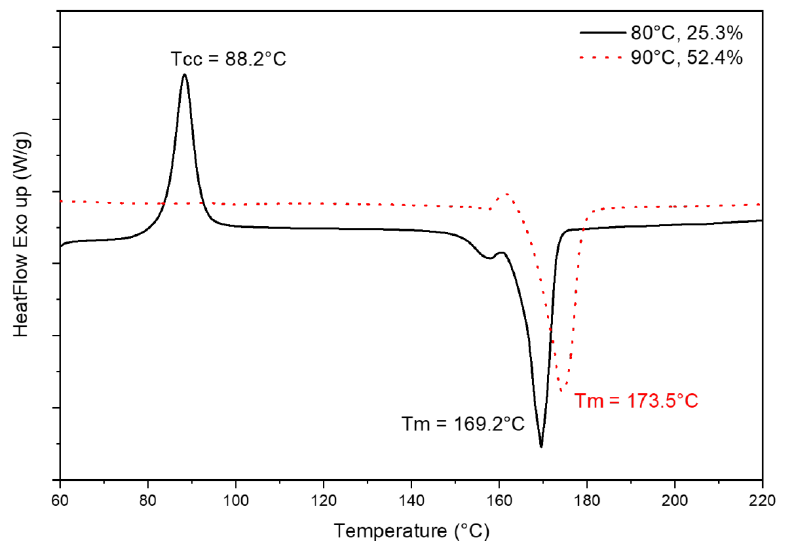
Figure 9. First heating cycle of DSC scans for PLA-OA blend at 80 °C and 90 °C temperature mold. Comparing the crystallinity of injection molded samples with the materials charac- terized at the same temperatures, it was observed that injection molded samples pre- sented higher crystallization than under quiescent conditions. At 80 °C, the crystallization process did not initiate after 180 s into the isotherm cycle under quiescent conditions, while for 90 °C DSC scan, the crystallinity was expected to be ~3.1% under quiescent con- ditions after 180 s. The significant difference between injection molded samples and sam- ples crystallized under quiescent conditions was due to the effect of shear stress intro- duced during the injection molding process. The effect of controlled shear stress on the crystallization behaviors during the injection molding of commercial PLA is presented in another research individually [22]. 5. Conclusions The main conclusions of this research are as follows: Orotic acid is an effective nucleating agent of PLA 2500HP over a wide range of tem- peratures from 80 °C to 120 °C. With the addition of only 1 wt.% of OA, the total crystal- linity obtained at 80 °C was 63% as compared to 26% for neat PLA. At 100 °C, the degree of crystallinity of the neat PLA and PLA-OA blends are similar. However, PLA-OA blend reduced the crystallization time from 80 min to less than 15 min. The time for samples to reach 25% crystallinity was reduced from 13 min for neat PLA to 6.5 min for PLA-OA blend. The 1 wt. % orotic acid is also capable of reducing the incubation time of PLA crys- tallization. At 100 °C, the incubation time was similar between neat PLA and PLA-OA blends, but at other temperatures, orotic acid can reduce the incubation time by at least 17%. The 1 wt.% orotic acid increased the initial crystallization rate at all isotherm temper- atures by enhancing the nucleation. The fitted crystallization rate factor k increased by two orders of magnitude. Avarmi index was between 1.2 and 1.7, indicating the formation of shish-kebab structures for all samples. At the fastest crystallization rate, the major